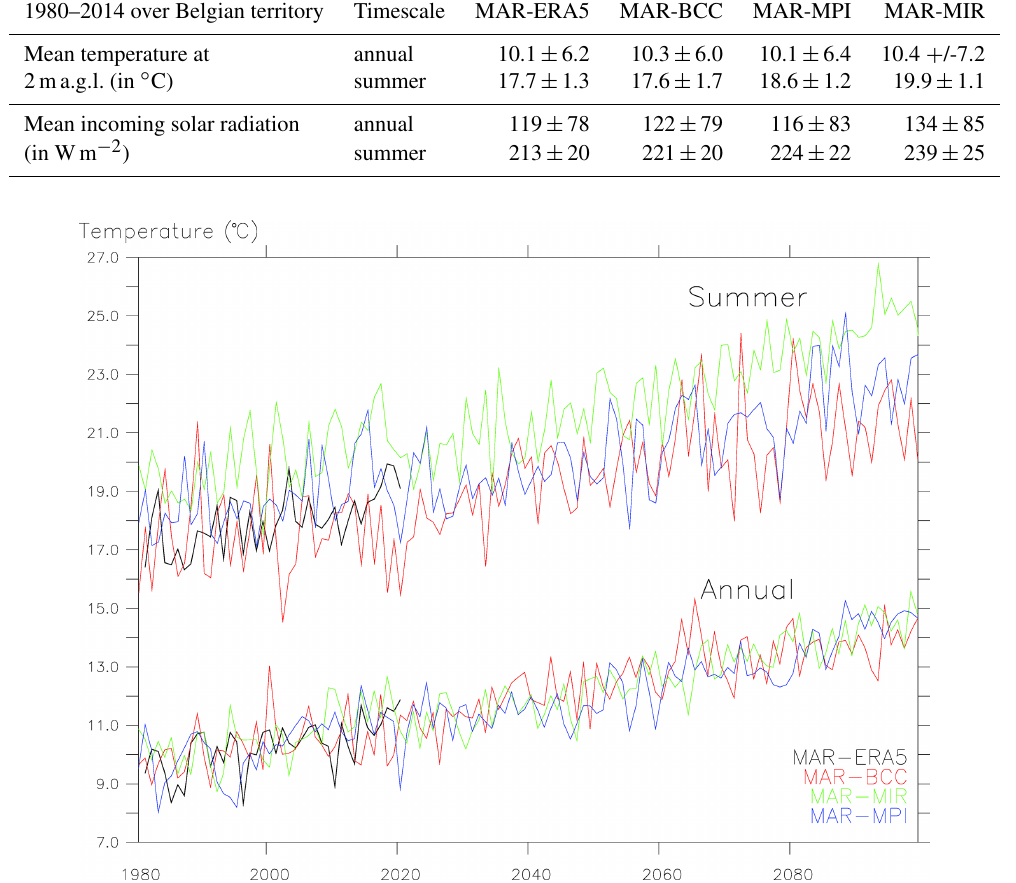
Figure 3. Annual mean temperature (in ◦ C, lower lines) and annual summer temperature (in ◦ C, upper lines) of MAR forced by ERA5 reanalysis (in black lines between 1980 and 2020), MAR-BCC (i.e. MAR forced by BCC-CSM2-MR in red lines), MAR-MPI (i.e. MAR forced by MPI-ESM.1.2 in blue lines), and MAR-MIR (i.e. MAR forced by MIROC6 in green lines) between 1980 and 2100 according to the scenario SSP5-8.5. The average is computed here over the whole integration domain, excluding the